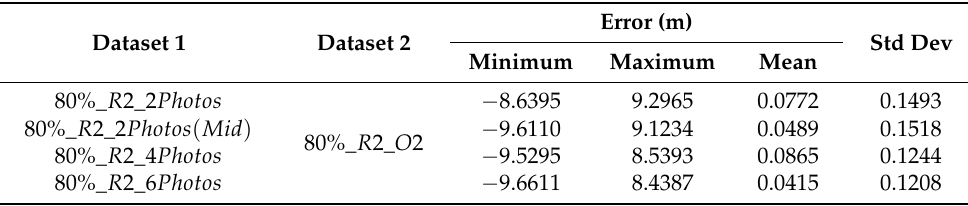
Table 8. Statistics of DoD external precision results of different oblique imaging numbers and location schemes.